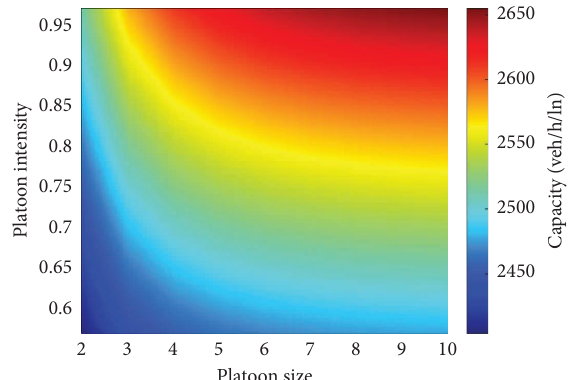
Figure 4: Capacity under diferent platoon intensities and maxi- mum platoon size with p � 0 . 7s.